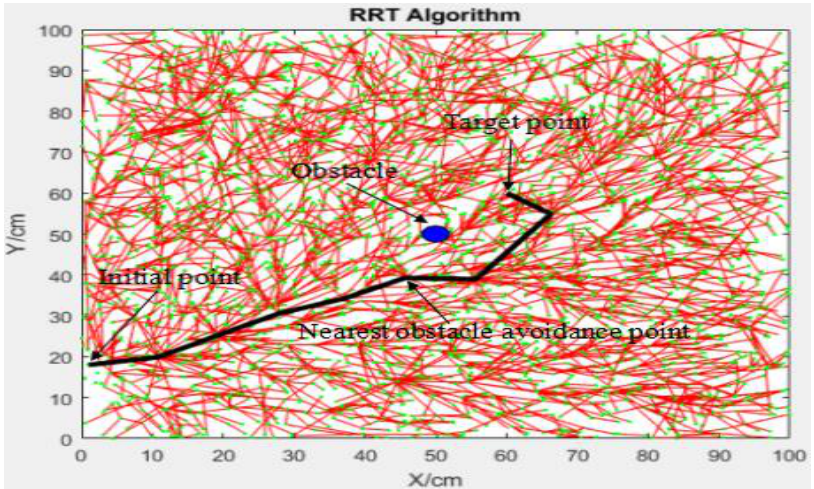
Figure 13. Trajectory planning of the RRT* method.